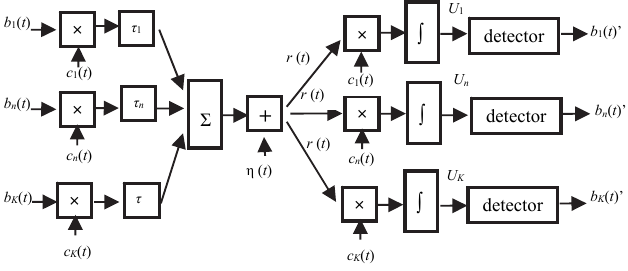
Fig. 1. Block diagram of asynchronous DS-CDMA baseband communication system